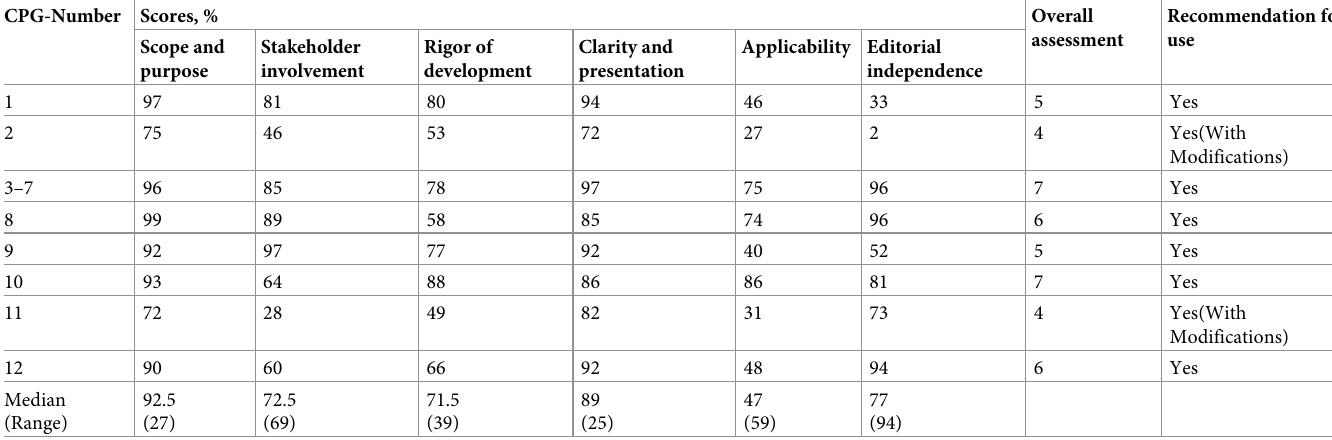
Table 2. Scaled domain percentages in the AGREE II for the different CPGs.